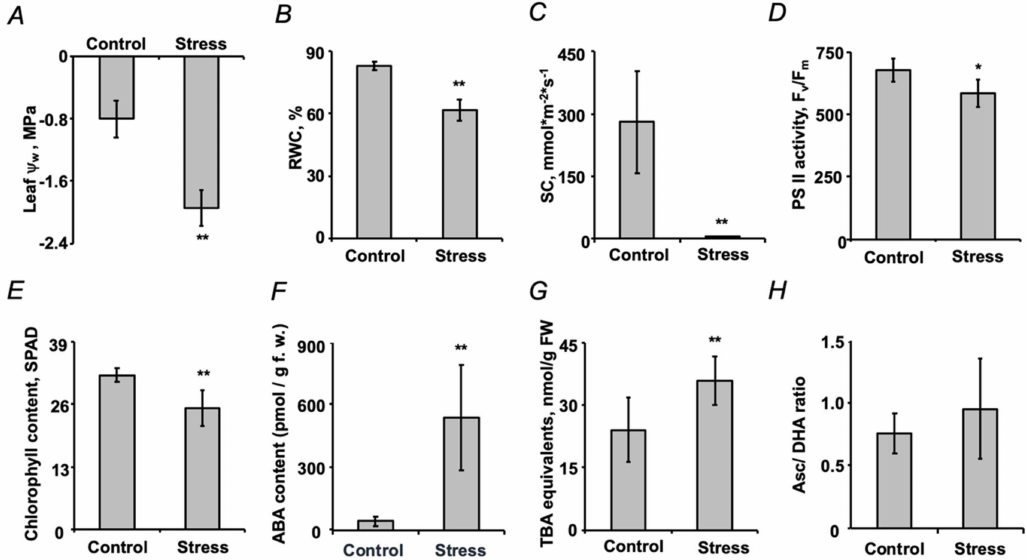
Figure 3. Characterization of plant stress after a two-day exposure of pea ( Pisum sativum L., cultivar SGE) plants to the aqueous medium with and without supplementation of 2.5% ( w / v ) PEG 8000 (defined as stress and control, respectively) by water potential ( A ), leaf relative water content (LRWC, B ), stomatal conductivity ( C ), photosystem II (PSII) e ffi ciency ( D ), chlorophyll content ( E ), the contents of abscisic acid (ABA, F ) and thiobarbituric acid-reactive substances (expressed as malondialdehyde equivalents, G ), as well as ascorbate / dehydroascorbate ratio ( H ). ** and * denote statistical significance ( t -test) at the confidence level p < 0.01 and p < 0.05,